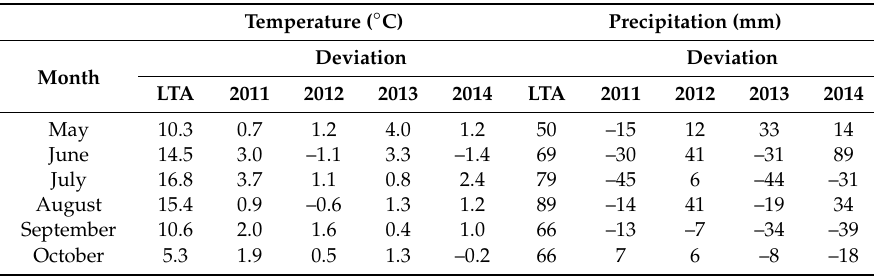
Table 2. Long-term monthly average of air temperature, sum of precipitation, and deviations from the